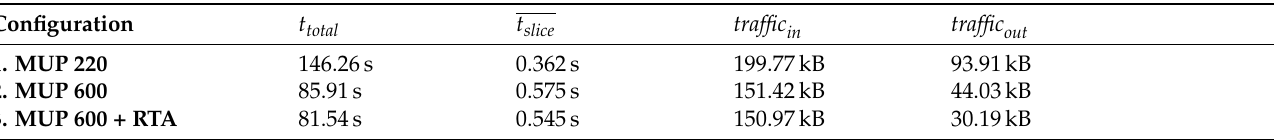
Table 7. Measured performance metrics of the three evaluated configurations: total duration of the transmission of the entire update file ( t total ), average duration of the transmission of a single update slice ( t slice ), total traffic over the wireless link to the IoT device ( traffic ) and from the IoT device ( traffic ). in out